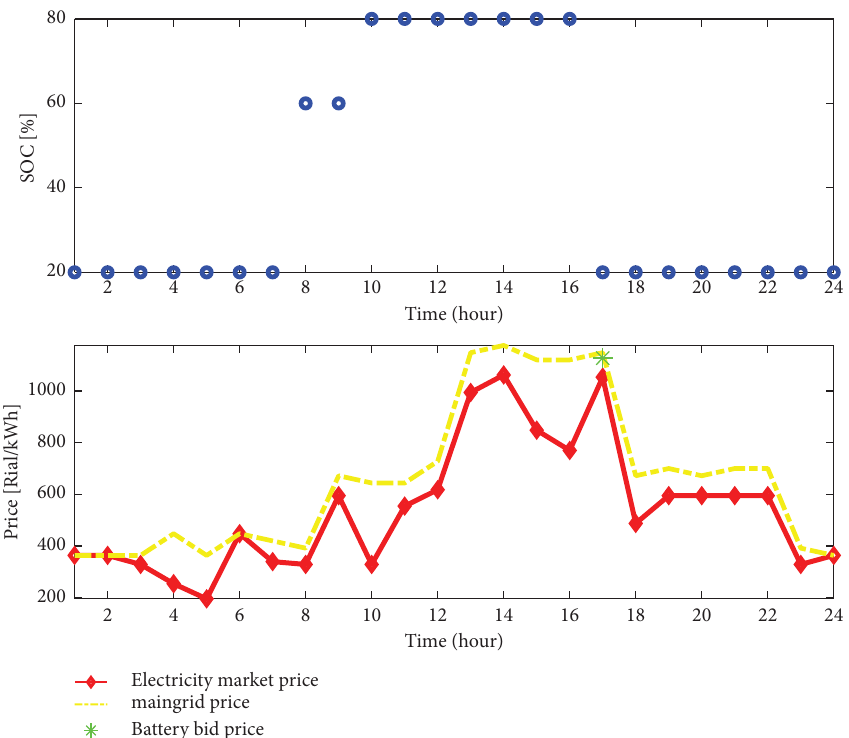
Figure 14: Te hourly SOC of the battery and the energy exchange